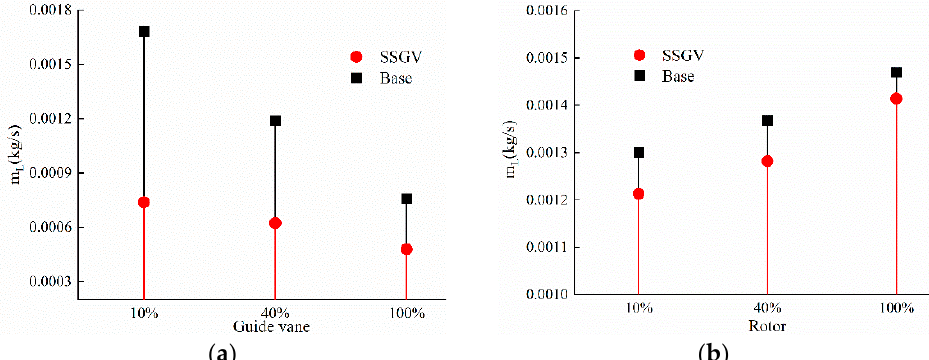
Figure 7. Comparison of the leakage flow between the two models: ( a ) guide vane clearance leakage flow; ( b ) rotor tip clearance leakage flow.